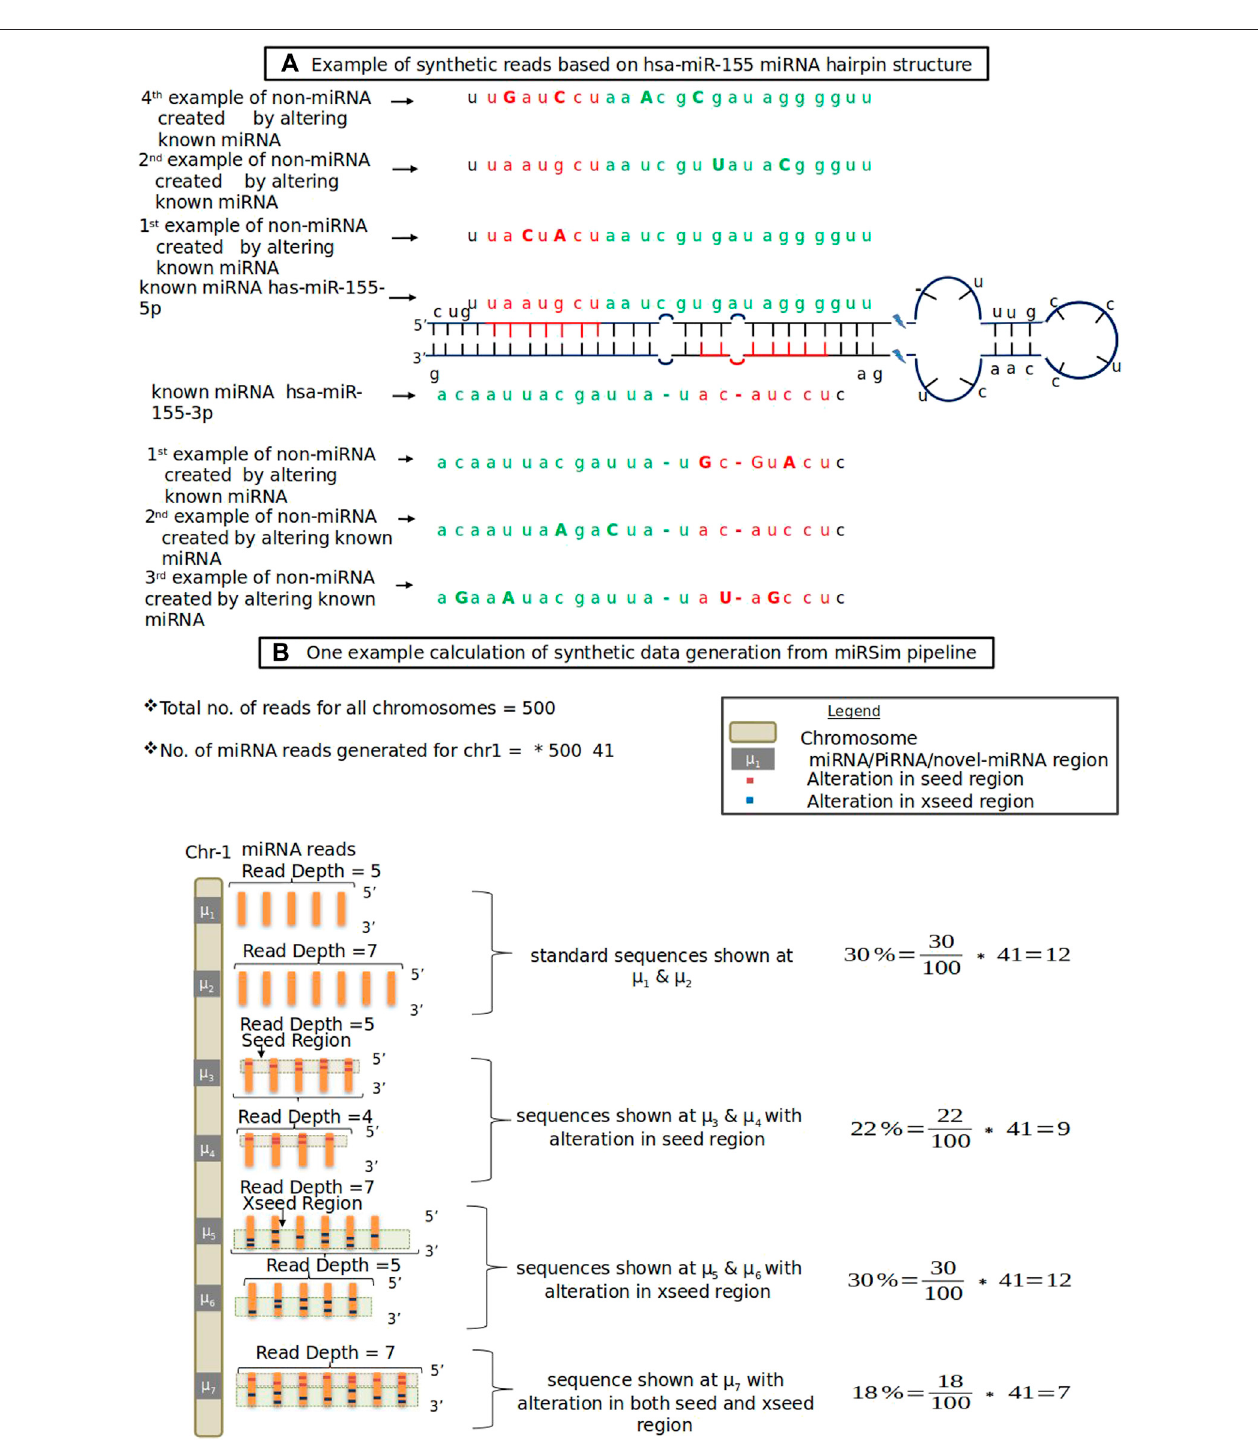
FIGURE 1 | (A) Example of synthetic reads based on hsa-miR-155 miRNA hairpin structure. Red color shows seed region, green color shows xseed region and capital letters denote altered nucleotide (B) One example data from miRSim pipeline. Here, the miRNA/piRNA region is represented by μ 1 , μ 2 , ... . Here μ 1 represents original miRNA and μ 2 - μ 7 are derived from μ 1 by alterations in the seed and xseed sequence of μ 1 and may or may not constitute avalid miRNA. The number of miRNAs present in the chromosome-1 and total number of miRNAs in all chromosomes are taken from miRBase (version22) (Kozomara et al., 2019)